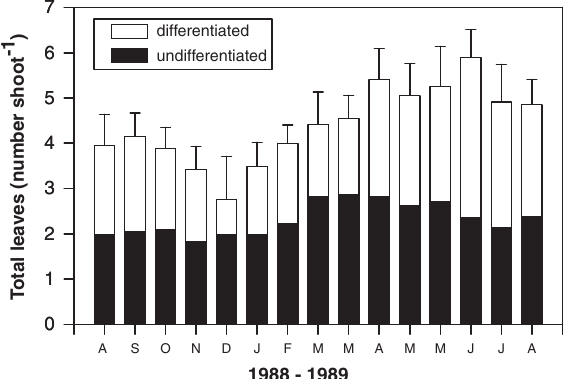
(Table 1). The remaining 63% of ungerminated seeds justified the high number of seeds recorded in the sediment all around the year (1399 ± 410). Comparing the variations in shoot density and the number of seedlings germinated during spring 1989, the contribution of sexual reproduction to the dynamics of this meadow varied between 3.3% (May) and 17% (July).